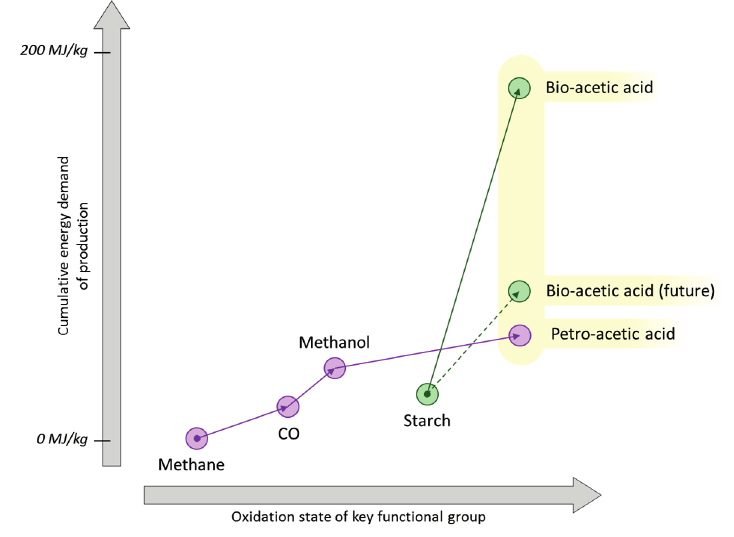
Figure 10. An indicative diagram plotting cumulative energy demand as a function of changing oxidation state for the production of acetic